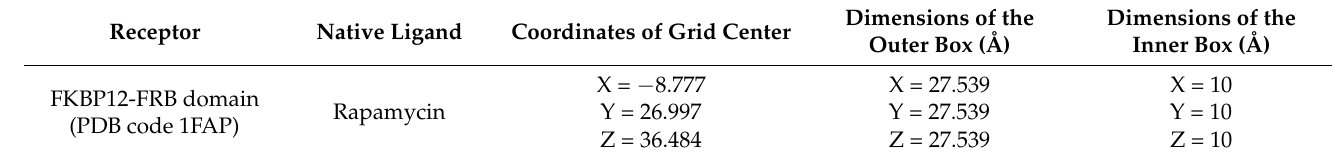
Table 1. Protocols used for molecular docking